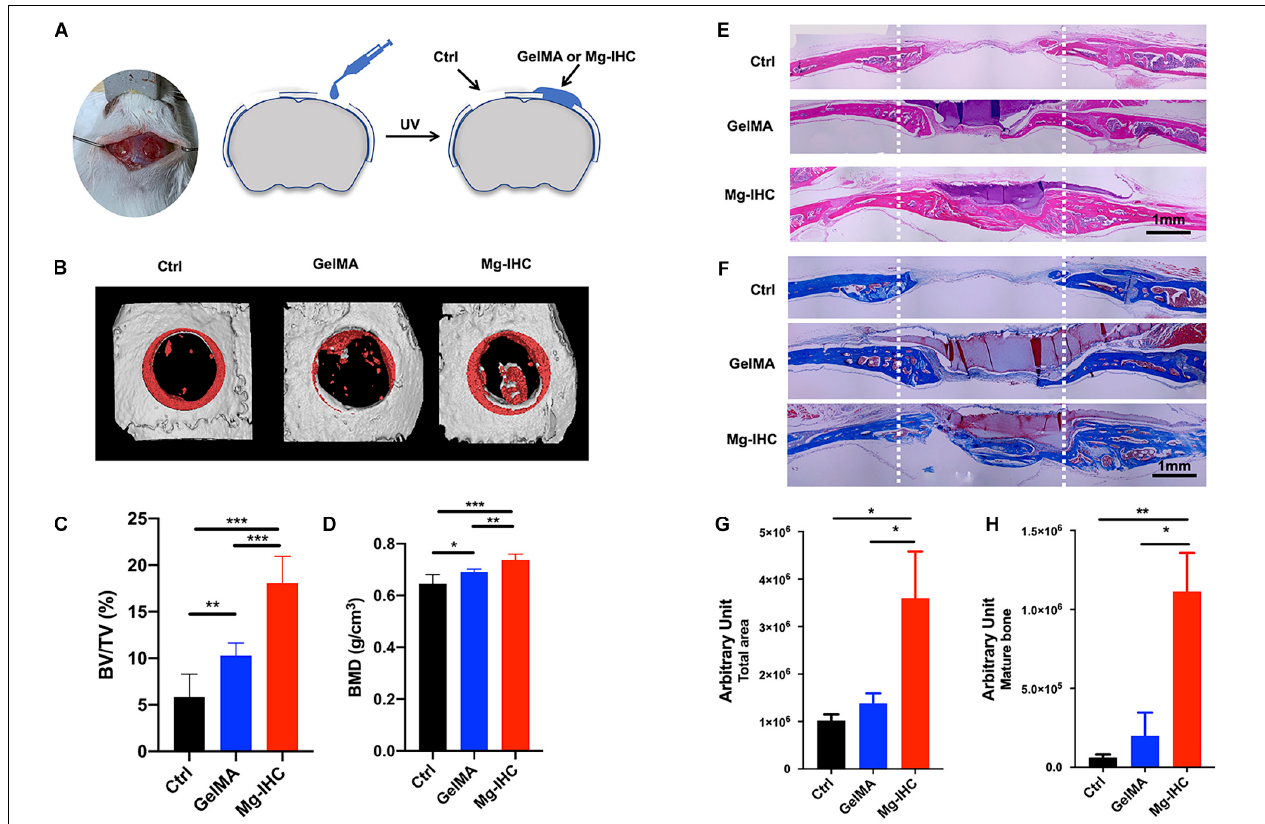
FIGURE 4 | Application of Mg-IHC to the repair of critical-sized calvarial defects in mice. (A) Schematic illustration of Mg-IHC for calvarial defects in mice. Four weeks after the use of Mg-IHC in mouse calvarial defects. (B) Schematic representation of micro-CT scan reconstruction. (C) Quantitative results of BV/TV. (D) Quantitative results of BMD. (E) Schematic diagram of H&E staining. (F) Schematic diagram of Masson staining. (G) Quantitative results of total neoplastic tissue at the defect site. (H) Quantitative results of mature bone at defect site. * P < 0.05; ** P < 0.01; *** P <